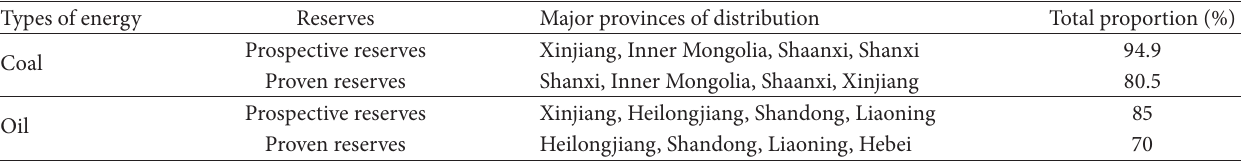
Table 4: China’s major sites of energy distribution.